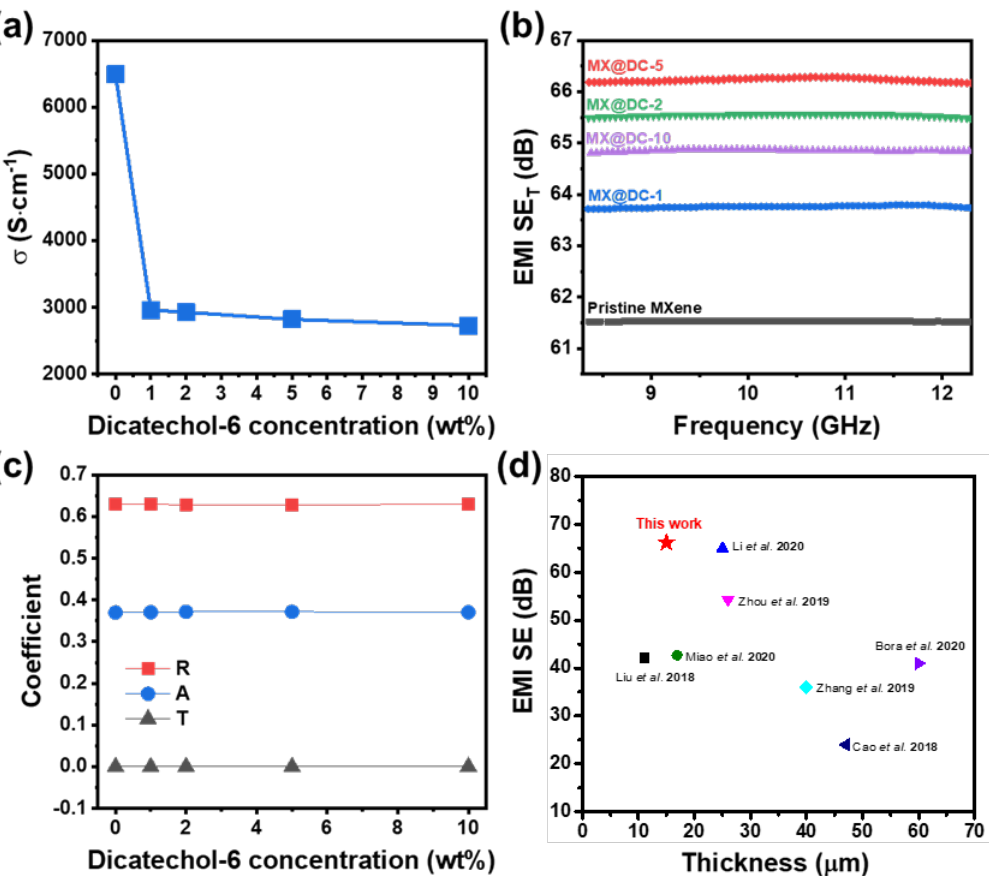
Figure 5. ( a ) Electrical conductivity, ( b ) EMI SE T , ( c ) Coefficient of reflection (R), absorption (A), and transmission (T) of the pure MXene and MX@DC − x films, respectively, ( d ) Comparison on EMI SE of the MXene films between our work and previous literatures [Ref. 29, 40, 58 −6 2].